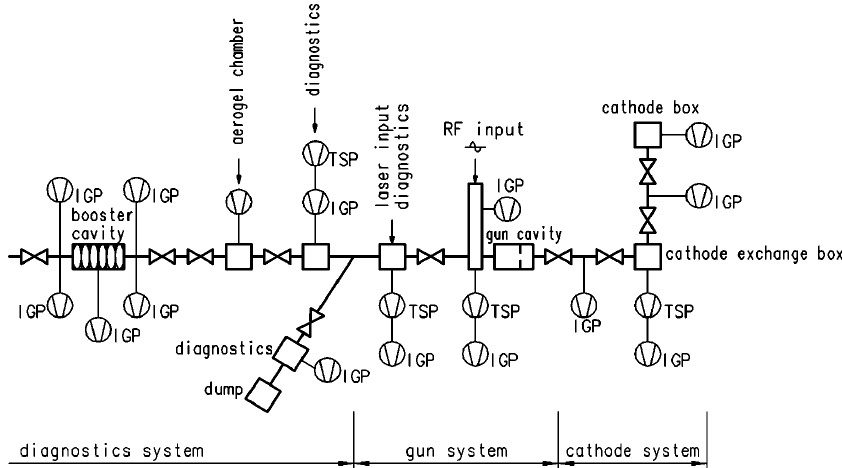
FIG. 4. Schematic diagram of the vacuum technical arrangement at PITZ, including the location of titanium sublimation pumps (TSP) and ion getter pumps